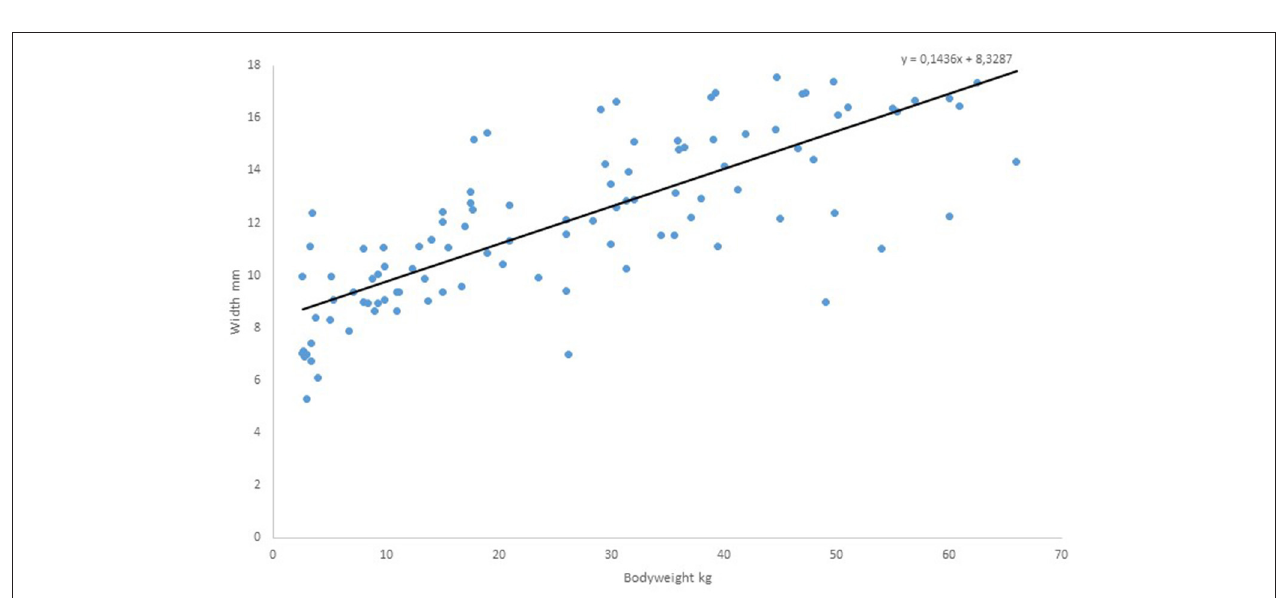
FIGURE 3 | Measured values of diameter of the esophagus as a function of body weight, lower measuring point.